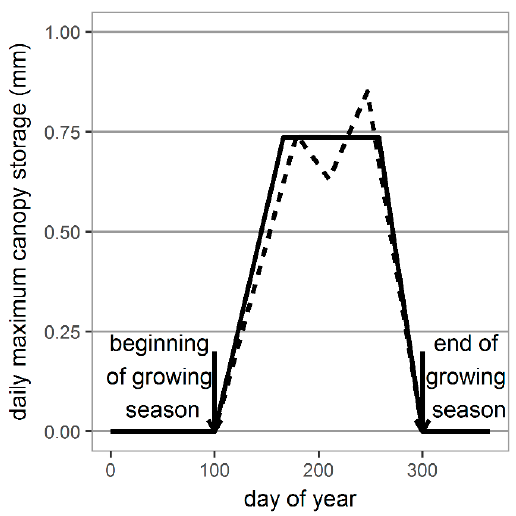
Figure 3 . Measured (dashed line) and mean of generated (solid line) daily maximum canopy storage.